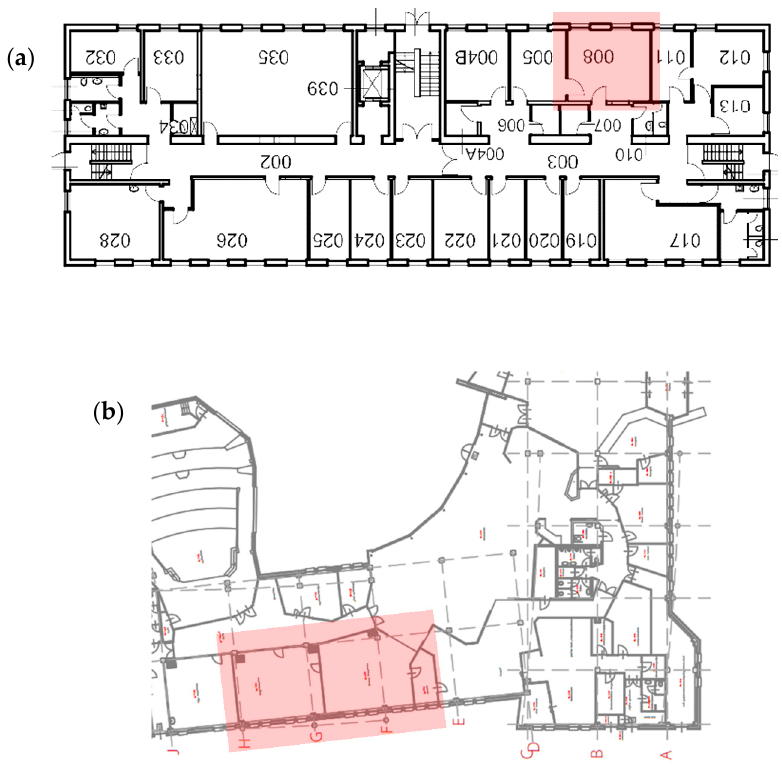
Figure 4. The floor plans for our two case studies. ( a ) ( top ) TU Braunschweig after the change (floor2), ( b ) ( bottom ) University of Twente ITC building (floor 1) before the change. The highlighted areas show the rooms where the changes happened.